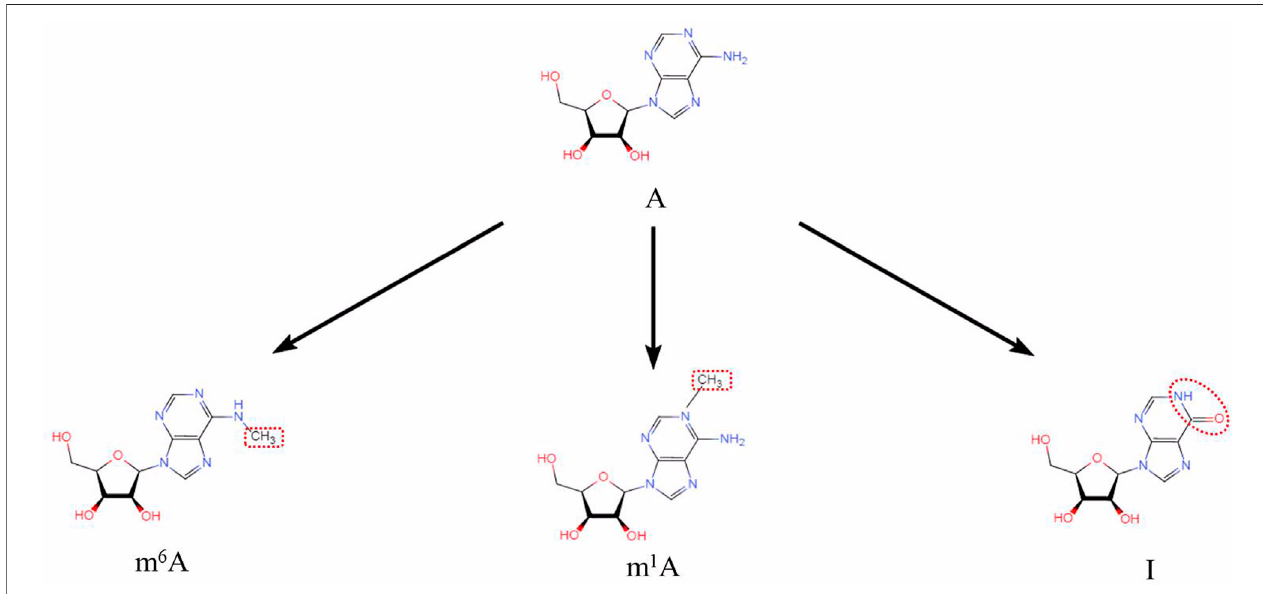
FIGURE 1 | Three adenine-associated RNA modi fi cations (N 6 -methyladenosine (m 6 A), N 1 -methyladenosine (m 1 A) and Adenosine to Inosine (A to I)). Chemical structures of three adenine-associated RNA modi fi cations are shown.